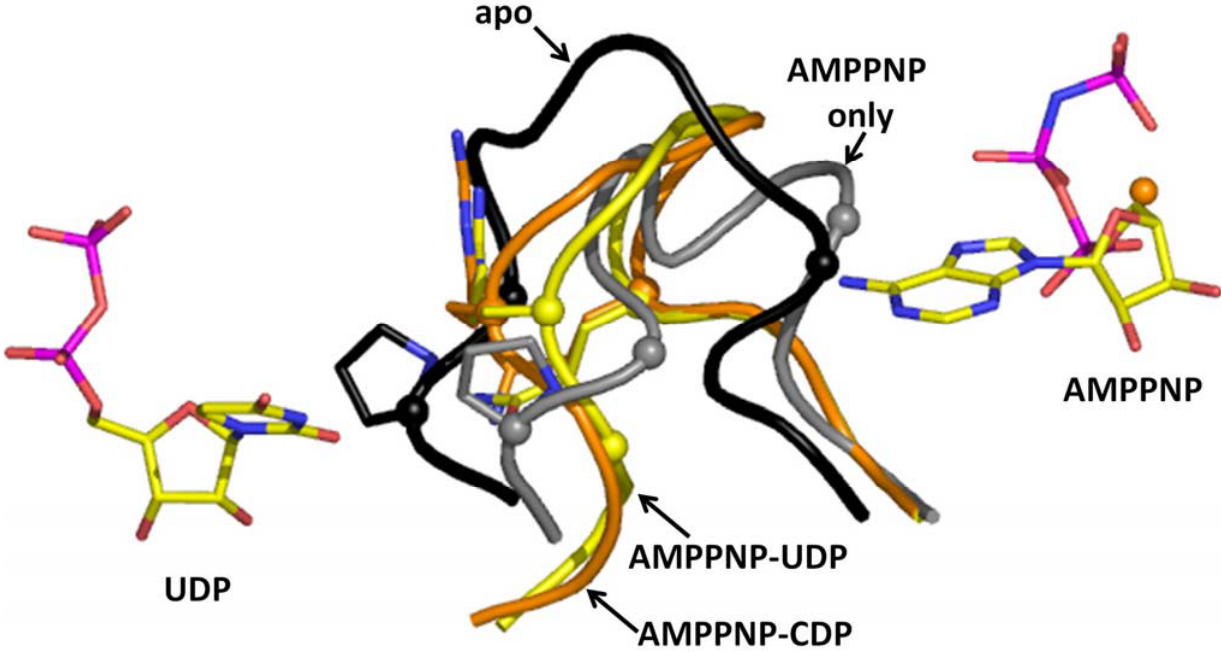
Figure 3. Loop 2 movements upon binding of effectors: Substrate (CDP) and loop 2 and effector (AMPPNP) are shown for AMPPNP-UDP. Loop 2 is shown for apo (black), AMPPNP only (gray), and AMPPNP-CDP(orange). Reproduced with permission from PNAS [13]. Copyright (2006) National Academy of Sciences, USA.